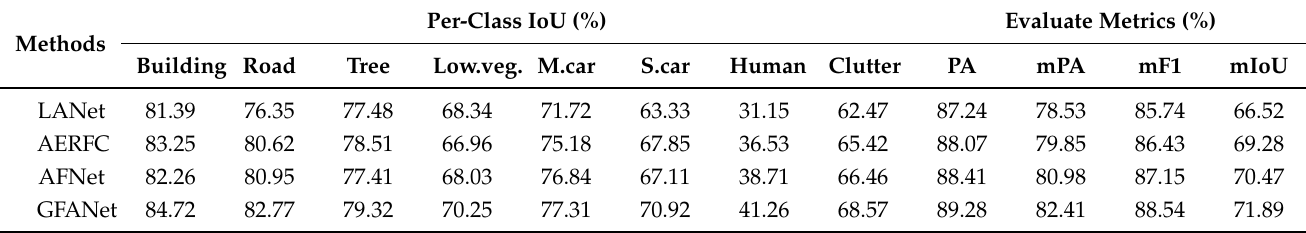
Table 1. Comparison of evaluation metrics on clean example test set in the UAVid